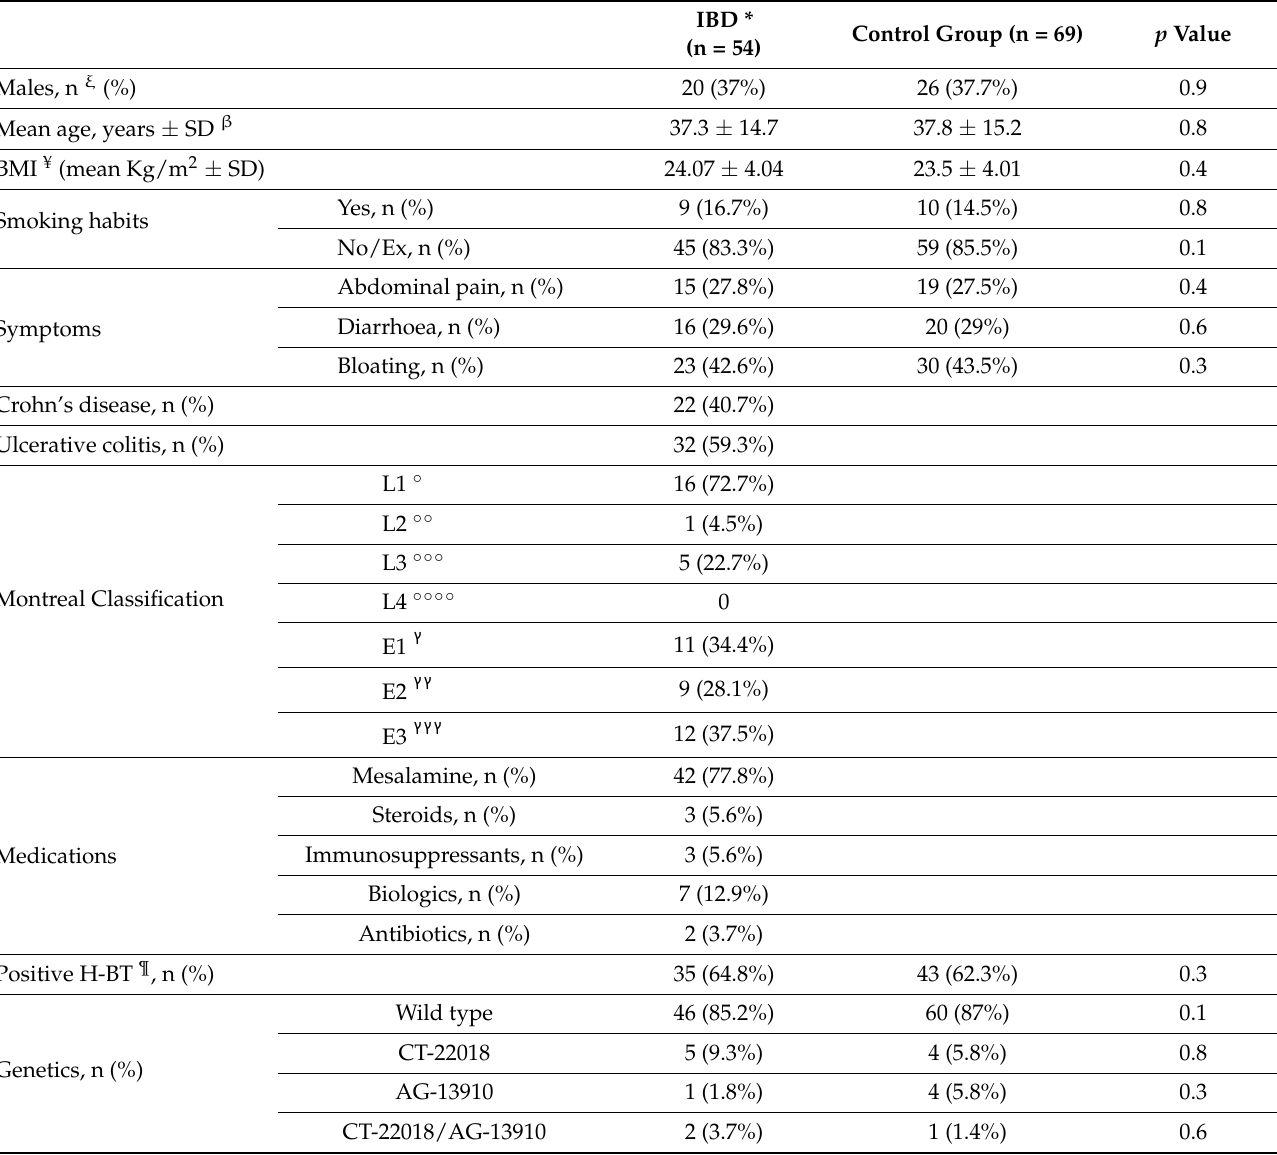
Table 1. Baseline patient demographics.